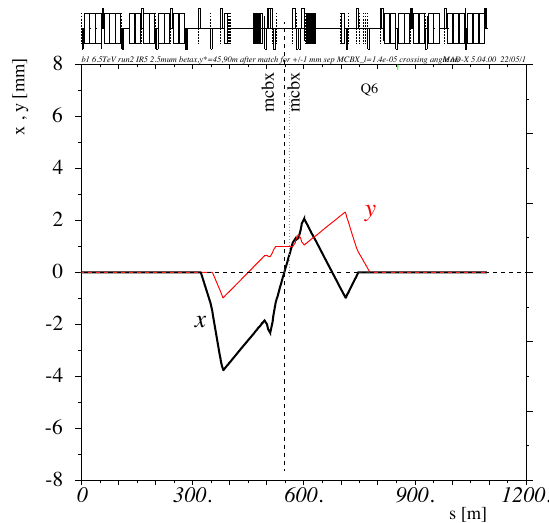
Figure 5. Magnet strength optimized separation and crossing bump, 45/90m optics, IP5,